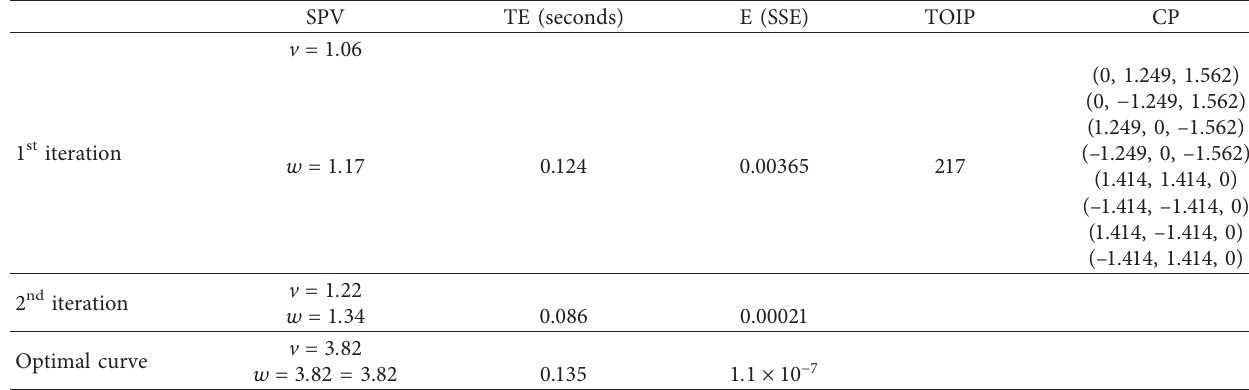
Table 2: Iterative values with characteristics points of Example 2.